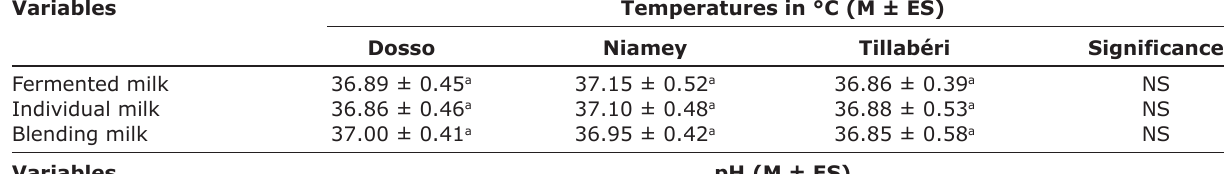
Table-3: Average values of temperature, pH, density, and titratable acidity of single milk, blended milk, and fermented milk according to region.